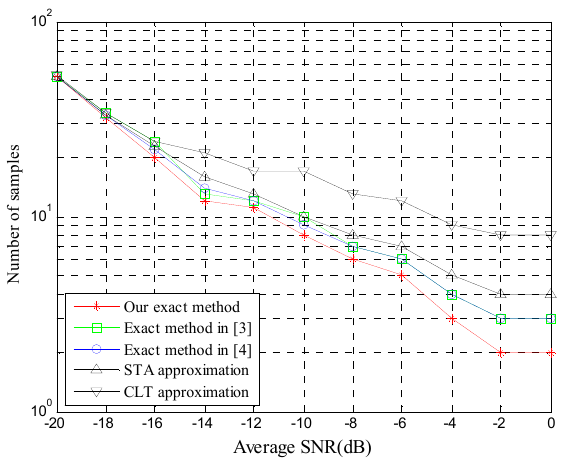
Figure 3. Sample size ( N ) vs. SNR for α = 2, µ =